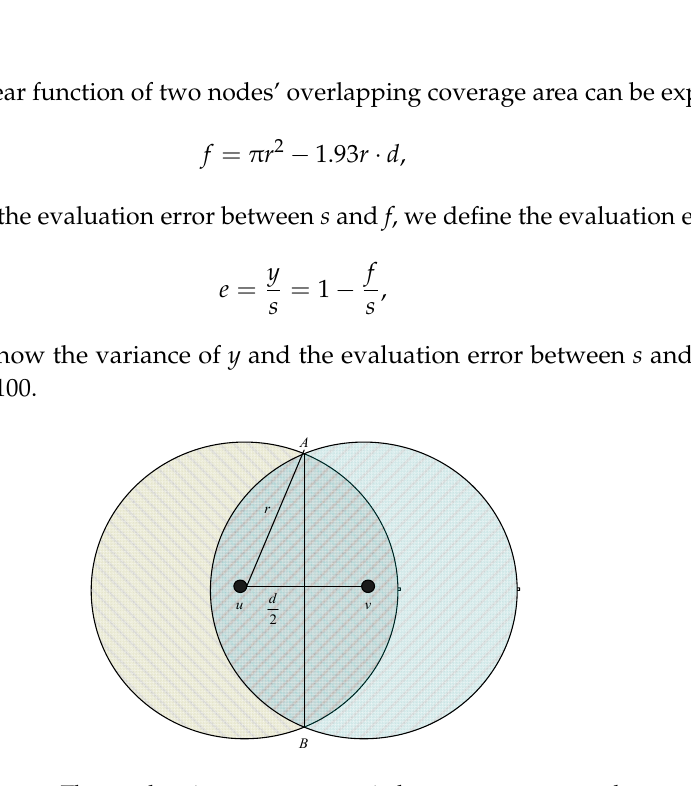
Figure 5. The overlapping coverage area in homogeneous networks.